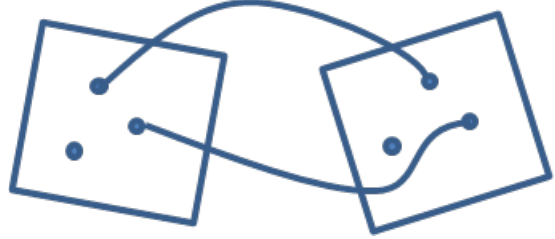
Figure 4. MicMac perform a check a-posteriori, verifying that the neighbours of a point in one image are also its neighbours in the